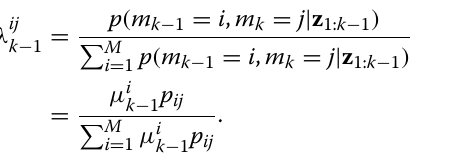
Note that (11) is a mixture of Gaussian distribution. The IMM algorithm approximates it by a Gaussian distribu- ¯ P j tion with mean ¯ x j and covariance k − 1 k − 1